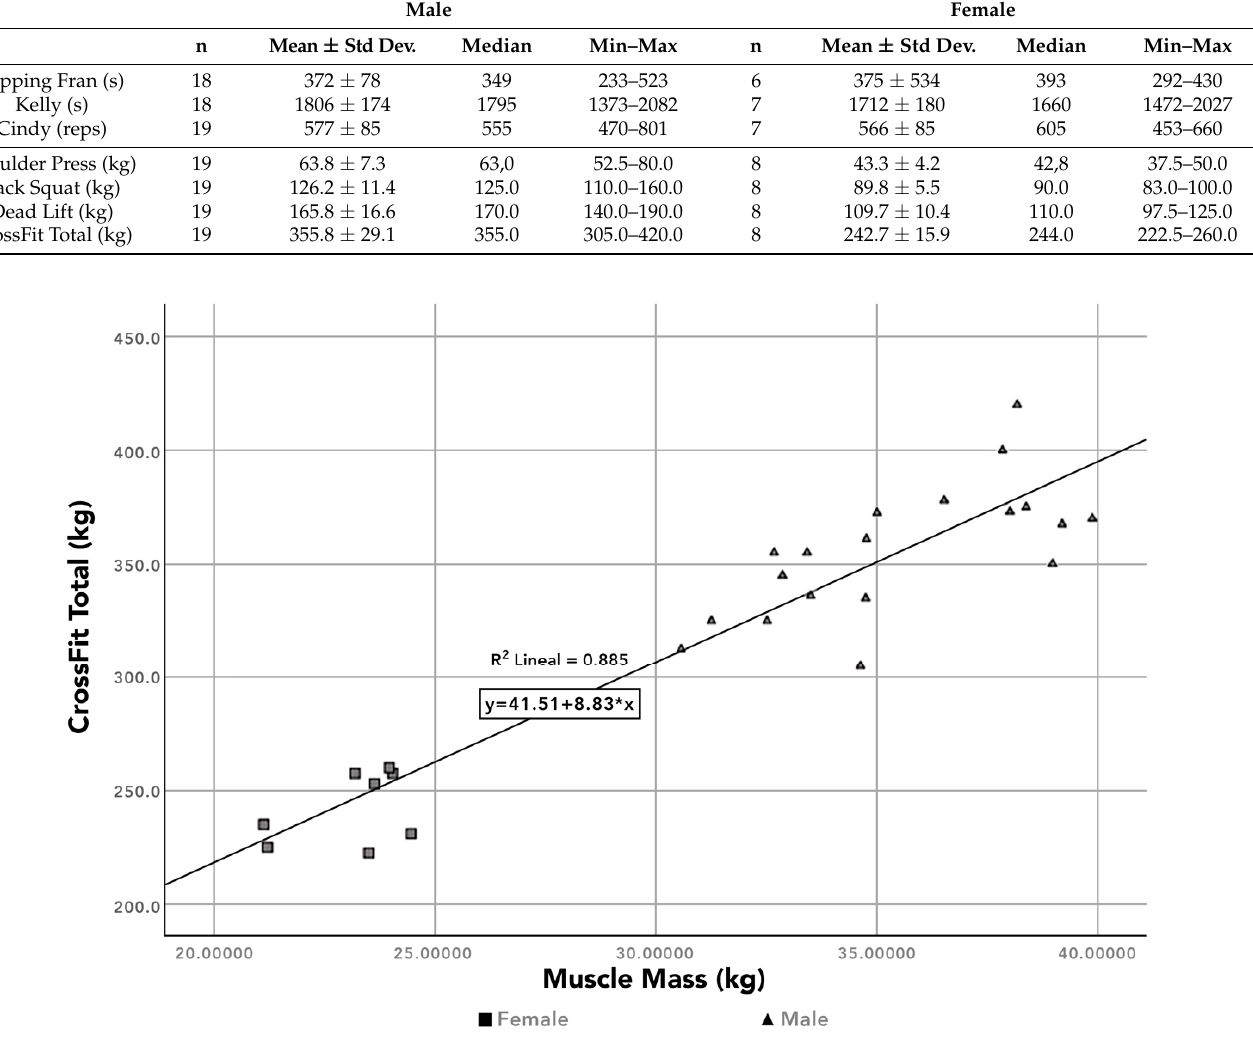
Figure 1. Correlation between muscle mass and weight lifted in CrossFit Total.